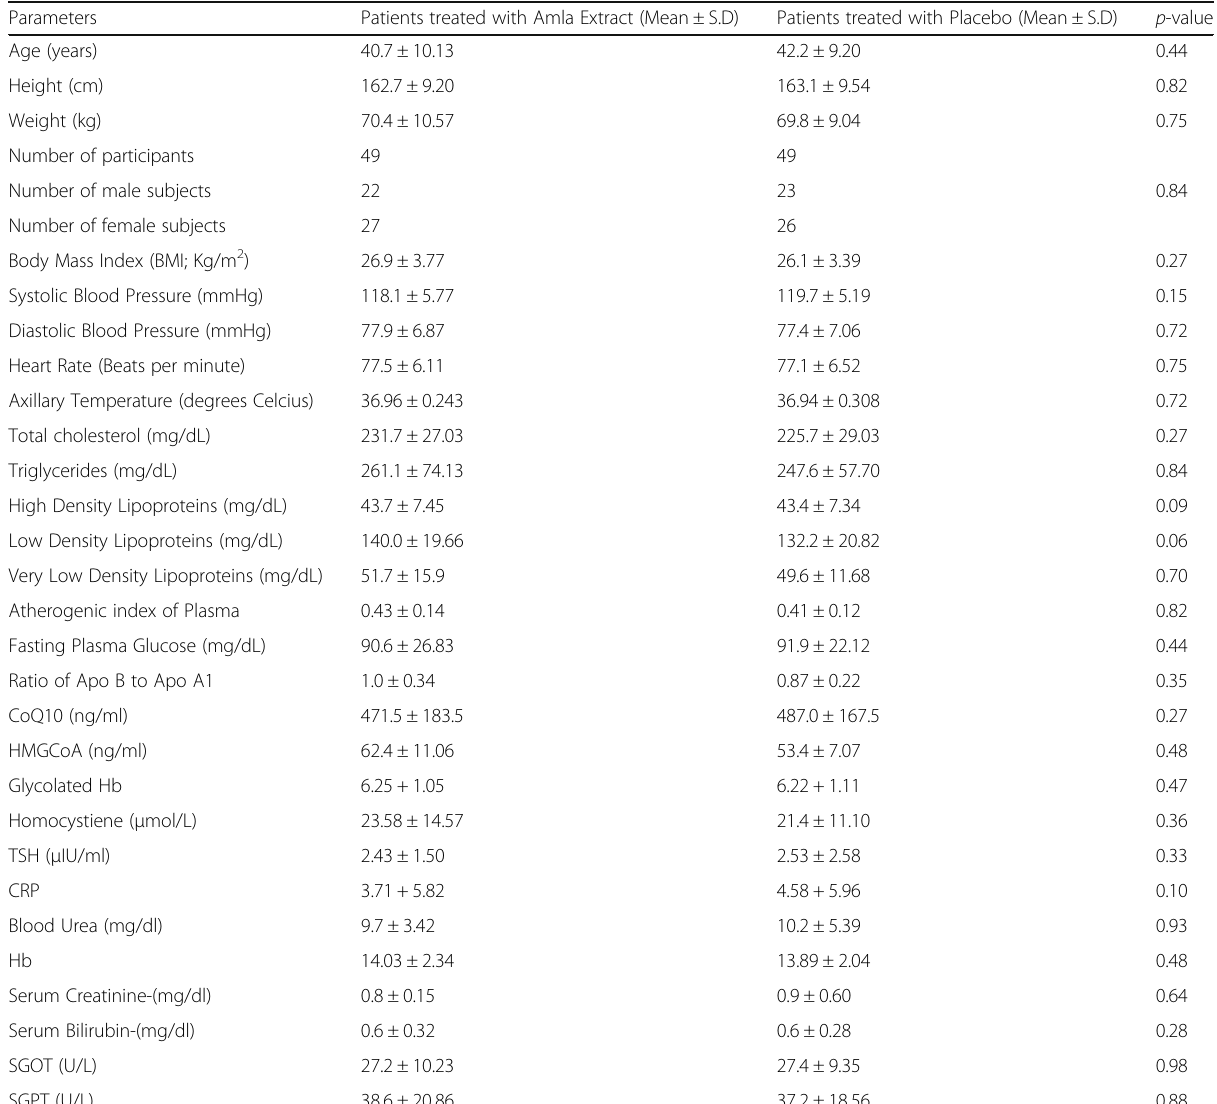
Table 1 Subject ’ s baseline data at the start of the study Parameters Patients treated with Amla Extract (Mean ± S.D) Patients treated with Placebo (Mean ± S.D) p